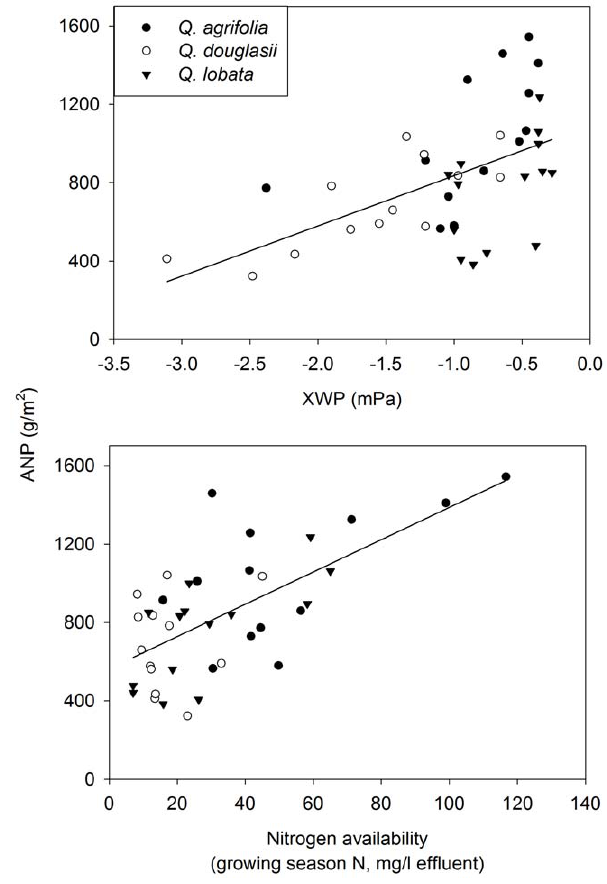
Figure 2. Five-year average ( ± SE) ANP of Quercus agrifolia (n=13), Q.douglasii (n=13 and Q.lobata (n=14) in relation to XWP and resin bag extracted nitrogen. Lines are drawn for statistically significant relationships based on the GLM (Table 1).